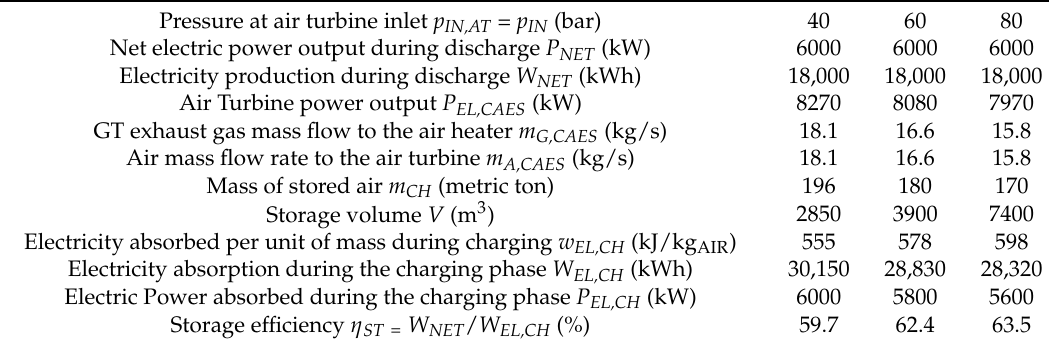
Table 2. Main CAES plants design data ( p ST = 100